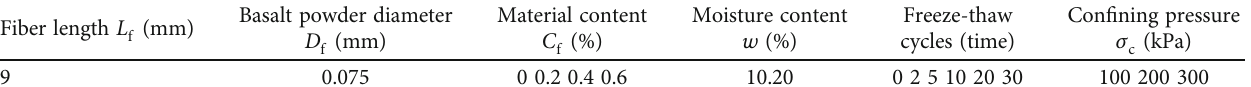
Table 4: Test program.